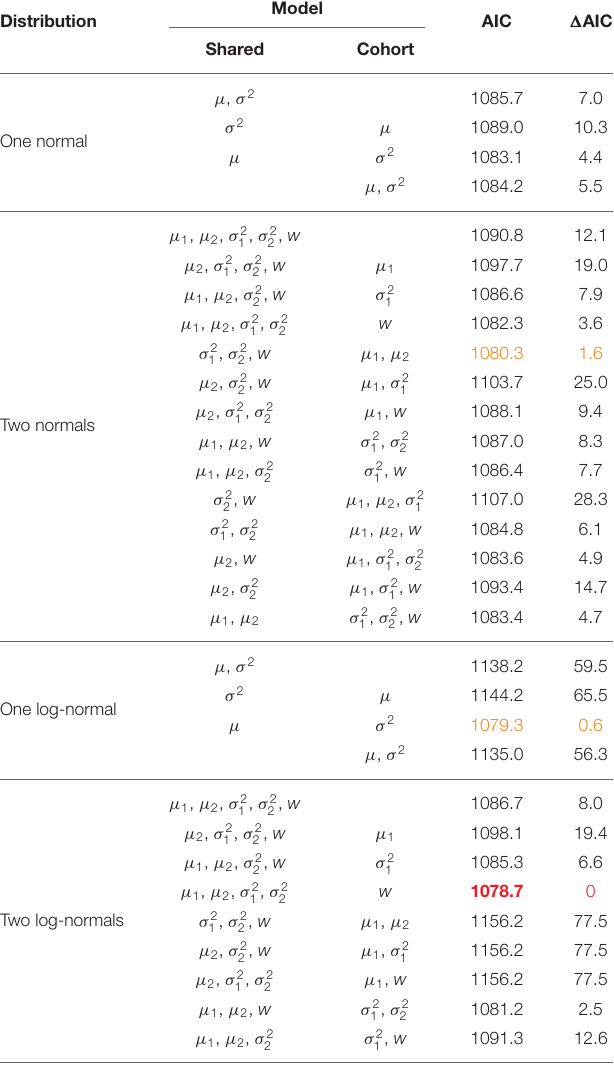
TABLE 4 | Parameter estimates, and 95% bootstrap confidence intervals, for the Isle of May gray seal study first-time and return breeder model with constant capture and survival probabilities and cohort dependent mixture proportions (two log-normal